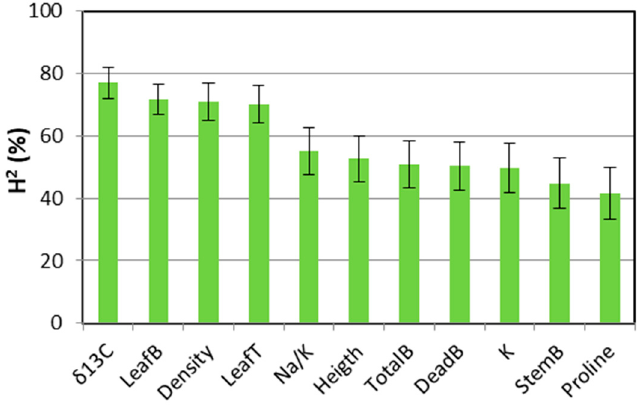
Figure 8. Broad-sense heritability (H 2 ) and standard errors (bars) for morpho-agronomic, physiological, and isotopic variables: stable isotopes of C ( δ 13 C); tiller density (Density); leaf length per tiller (LeafT); leaf (LeafB), stem (StemB), dead (DeadB), and total (TotalB) biomass dry weight; Na + /K + ratio (Na/K); plant height (Height); and K + concentration (K).